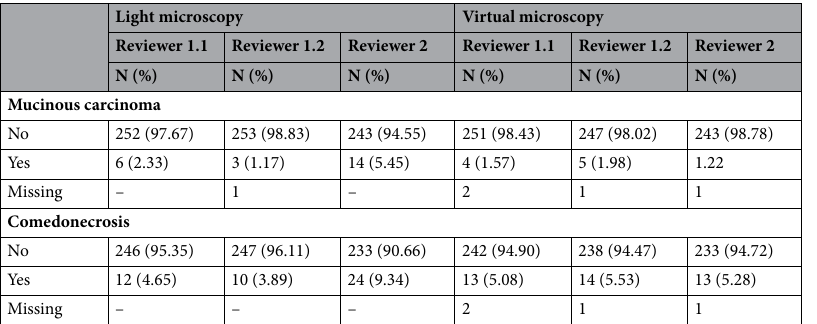
Table 2. Histopathological characteristic evaluated on the core level for the 413 cores which were evaluated by both reviewers using both the light and virtual microscopy. N sample size; SD standard deviation; Reviewer